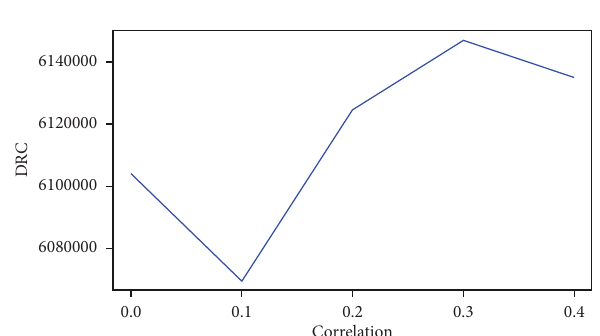
Figure 8: DRC evolution with respect to the correlation.